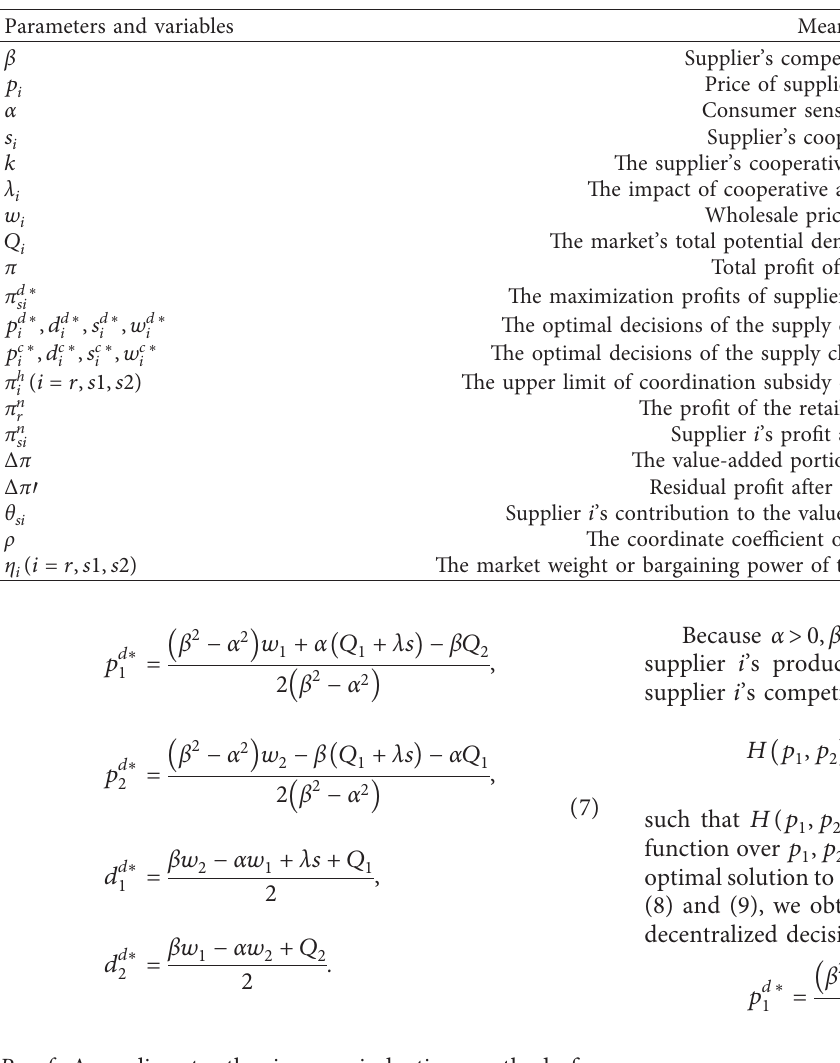
Table 2: Decision variables and